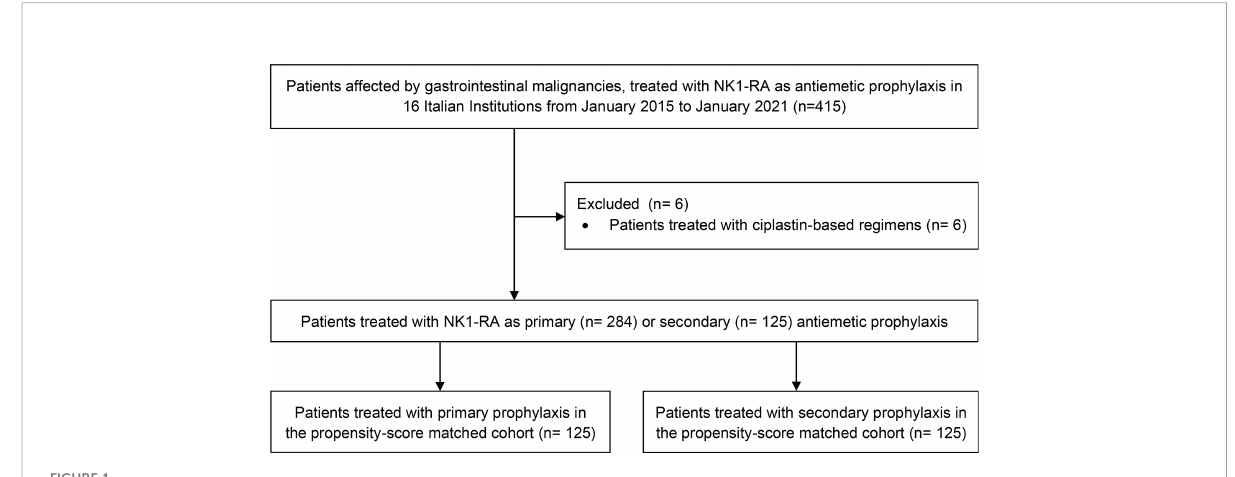
FIGURE 1 CONSORT diagram with patients selection and